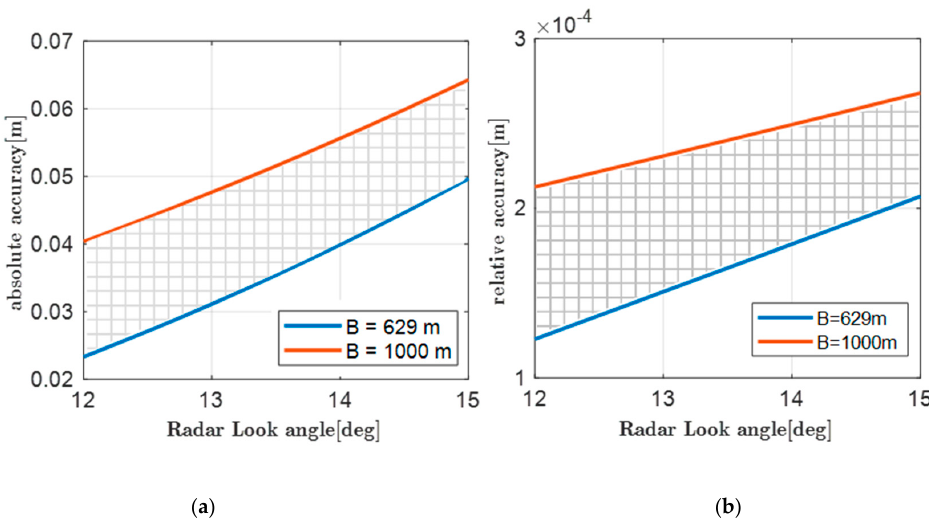
Figure 17. The altimetric accuracy determined by a baseline length error of 1 mm. ( a ) The absolute accuracy and ( b ) the relative accuracy.